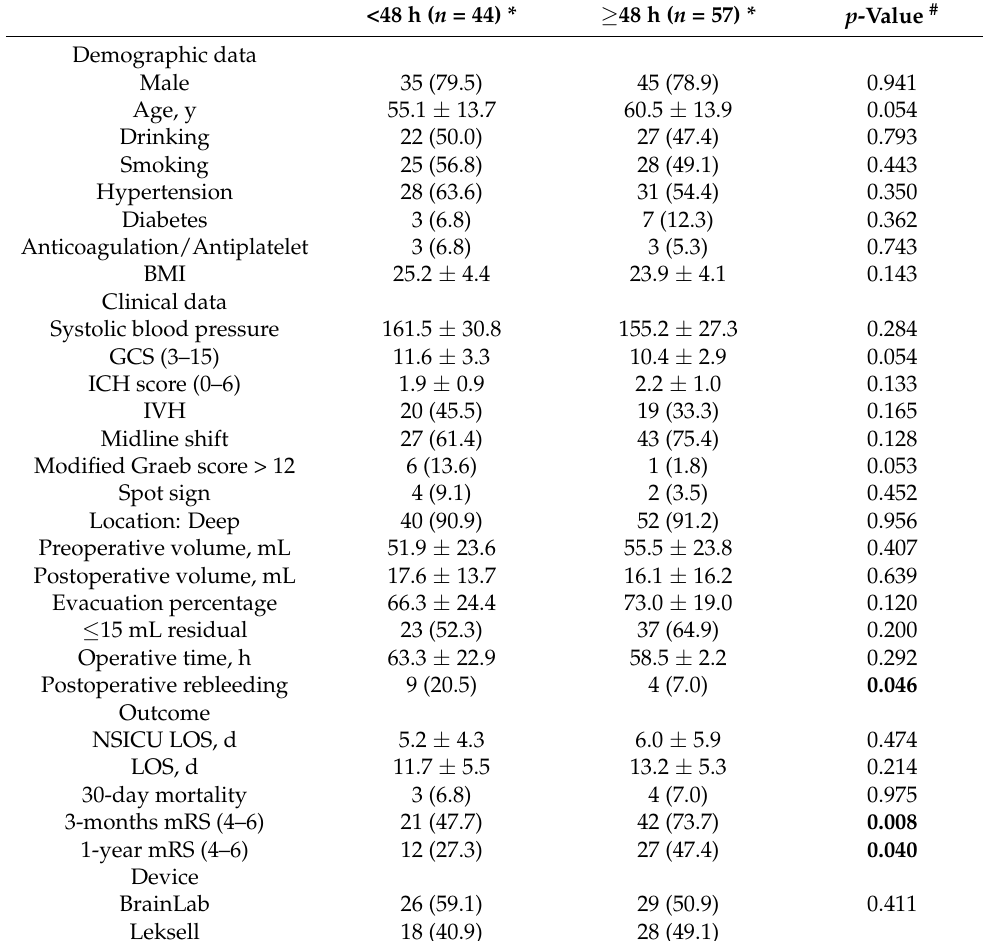
Table 6. Univariate analysis for patients performed surgery within 48 h and beyond 48